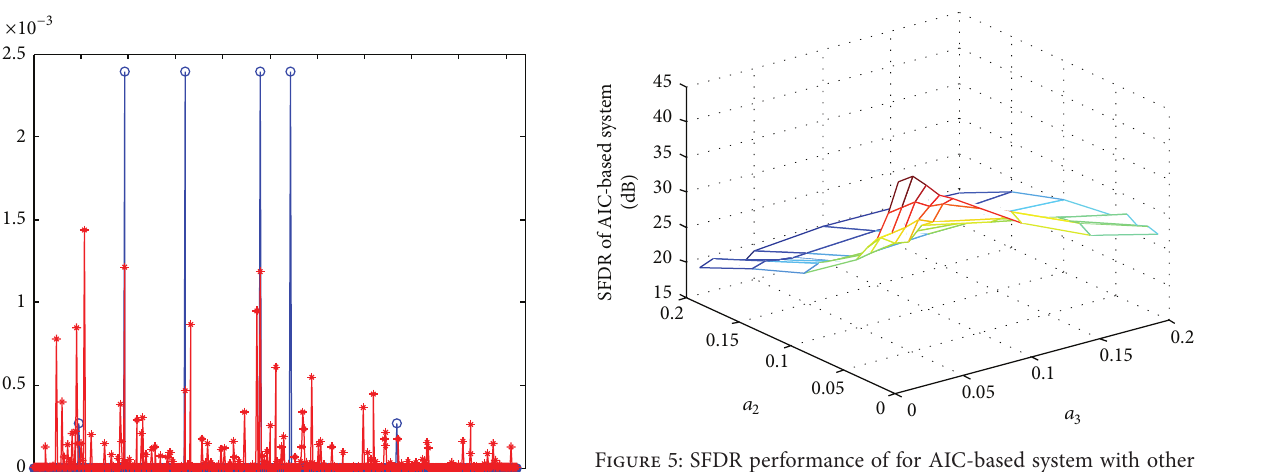
Figure 5: SFDR performance of for AIC-based system with other nonlinear